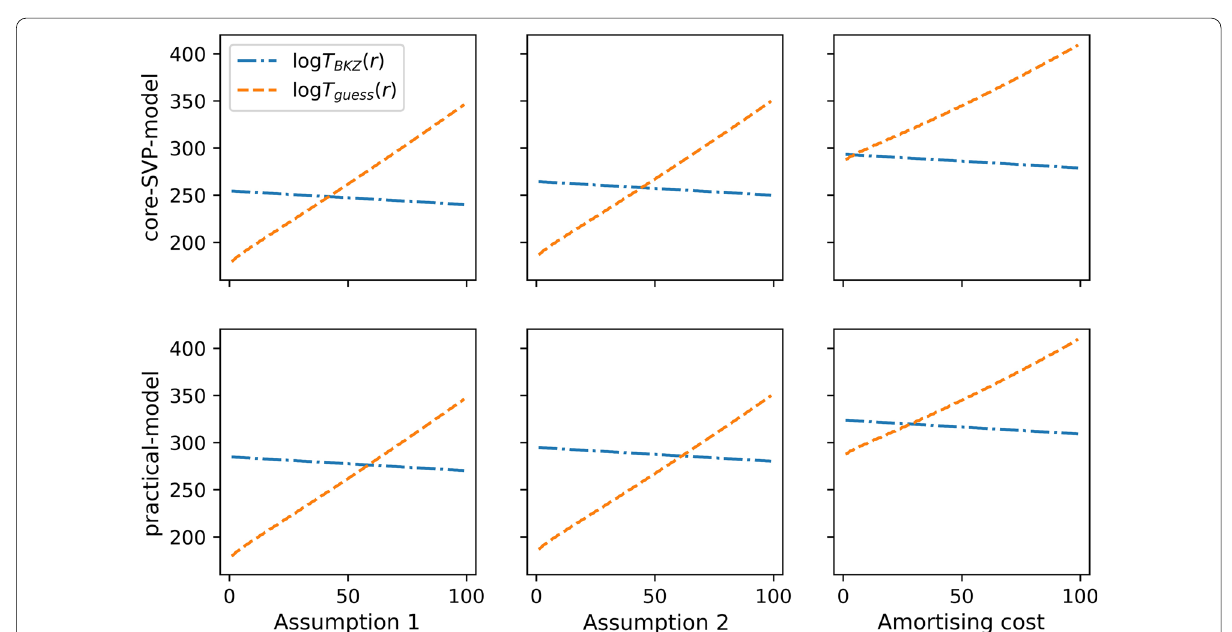
Fig. 3 Example: T BKZ and T guess as a function of r for Kyber1024 under different cost models and